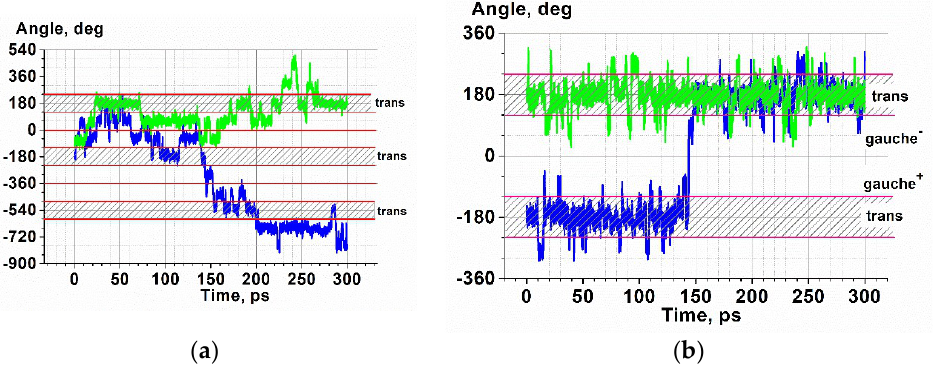
Figure 12. Time evolution of the rotational angles around the Si-C bonds ( a ) and around the C-C bonds ( b ) for sixth layer of the c3-dendrimers of the sixth generation.